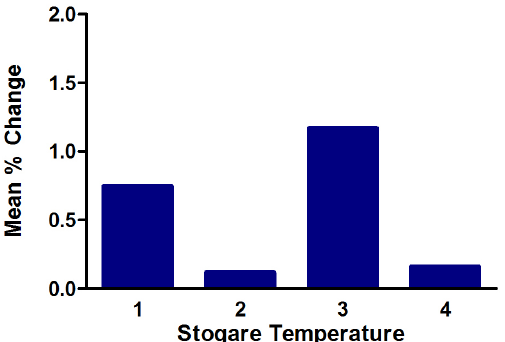
µg/mL) of plant extracts alone and emulsions containing plant extracts 50